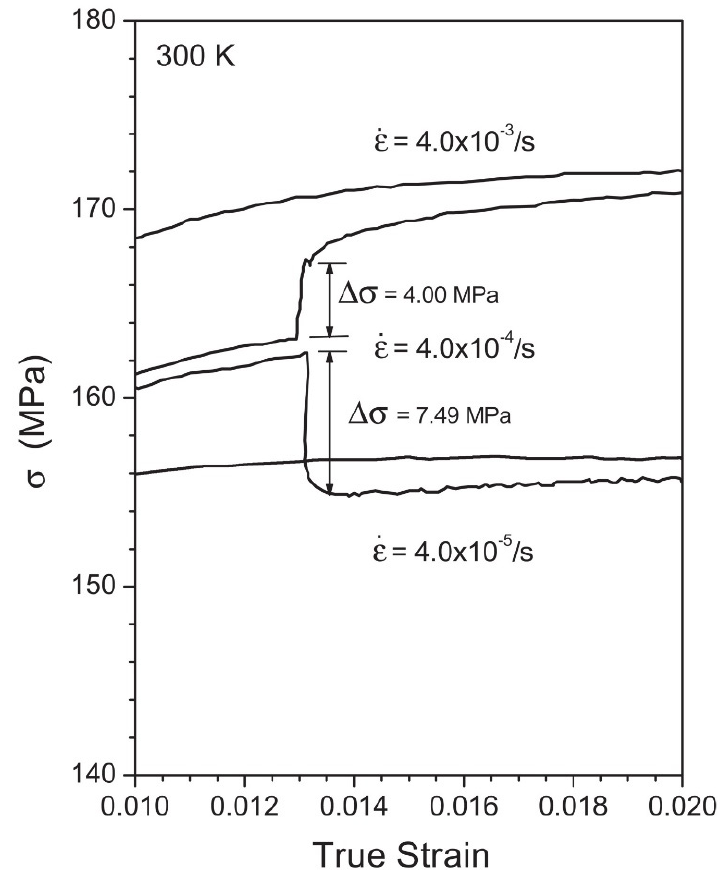
Figure 1. PSRS strain-rate change at 300 K in tension for Al-0.5% Fe alloy after rolling pre-strain to ε = 1.45 and testing at constant strain rates of 4 × 10 − 3 , 4 × 10 − 4 and 4 × 10 − 5 s − 1 , the intermediate rate with strain rate changes at ~0.13 strain. Note ∆ σ up < ∆ σ down and the mechanical equation of state is not satisfied.